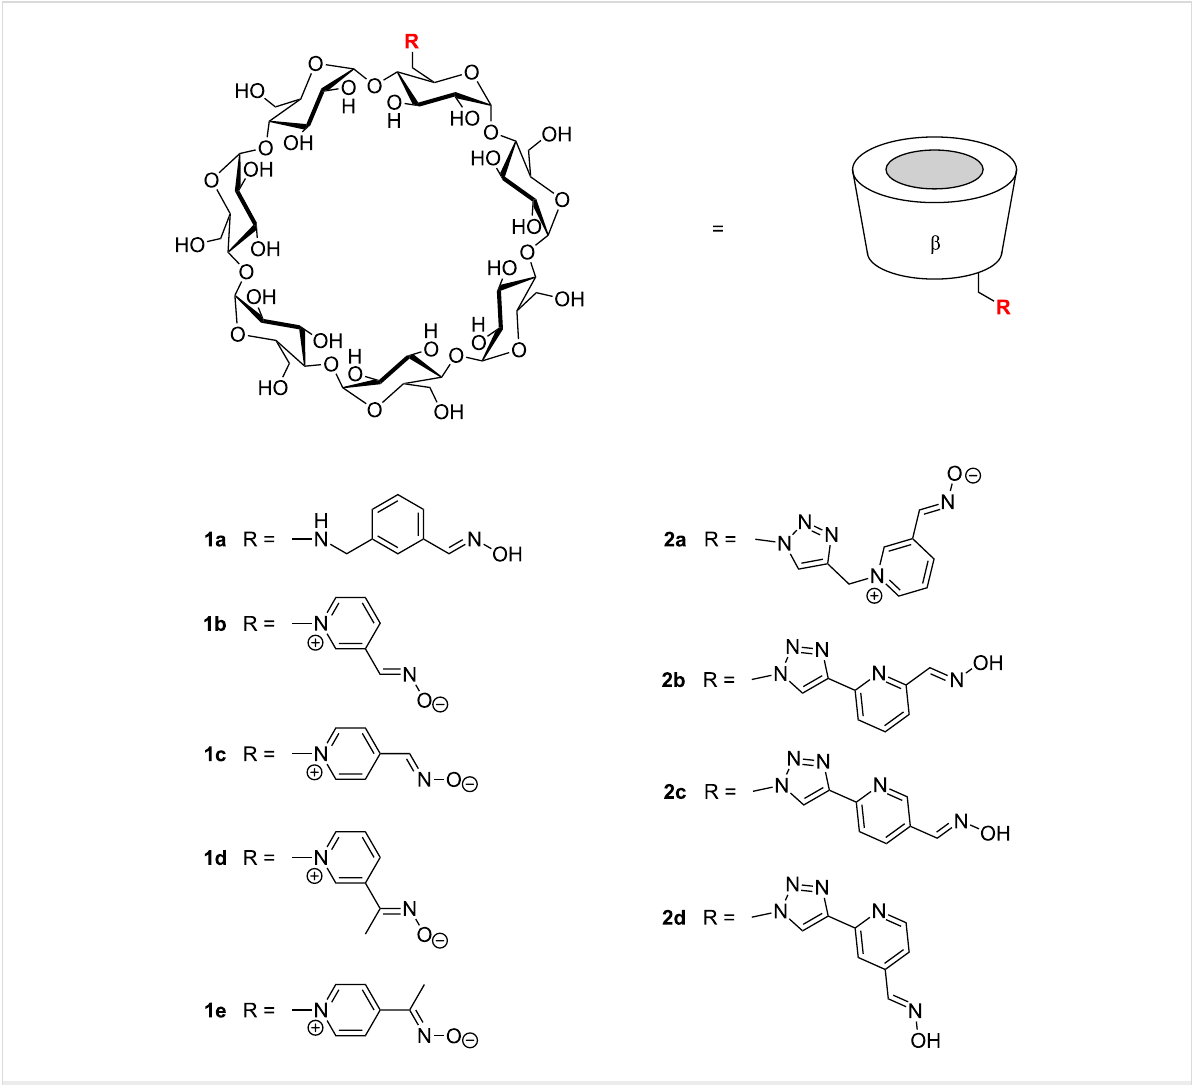
Scheme 2: Cyclodextrin derivatives tested as potential GF